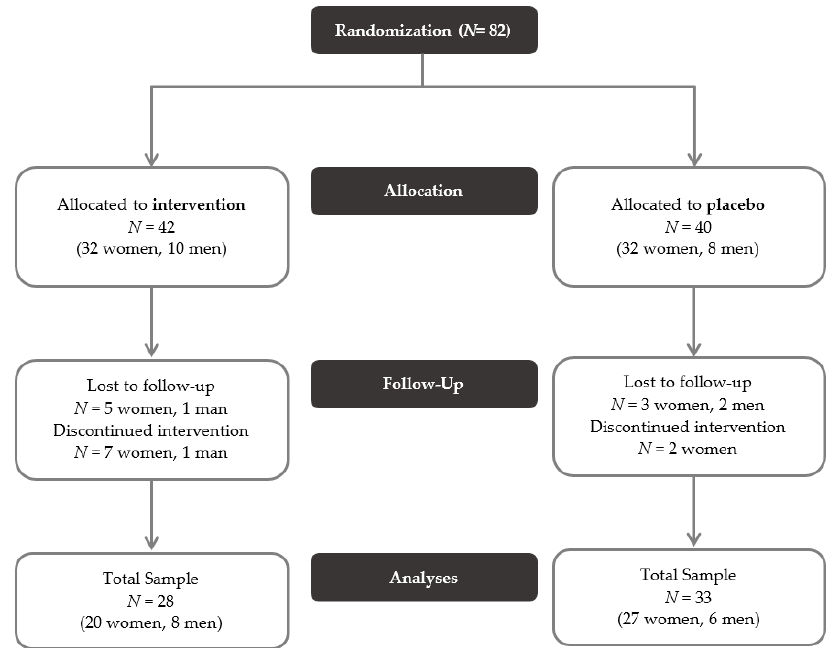
Figure 1. CONSORT flow diagram of the PROVIT